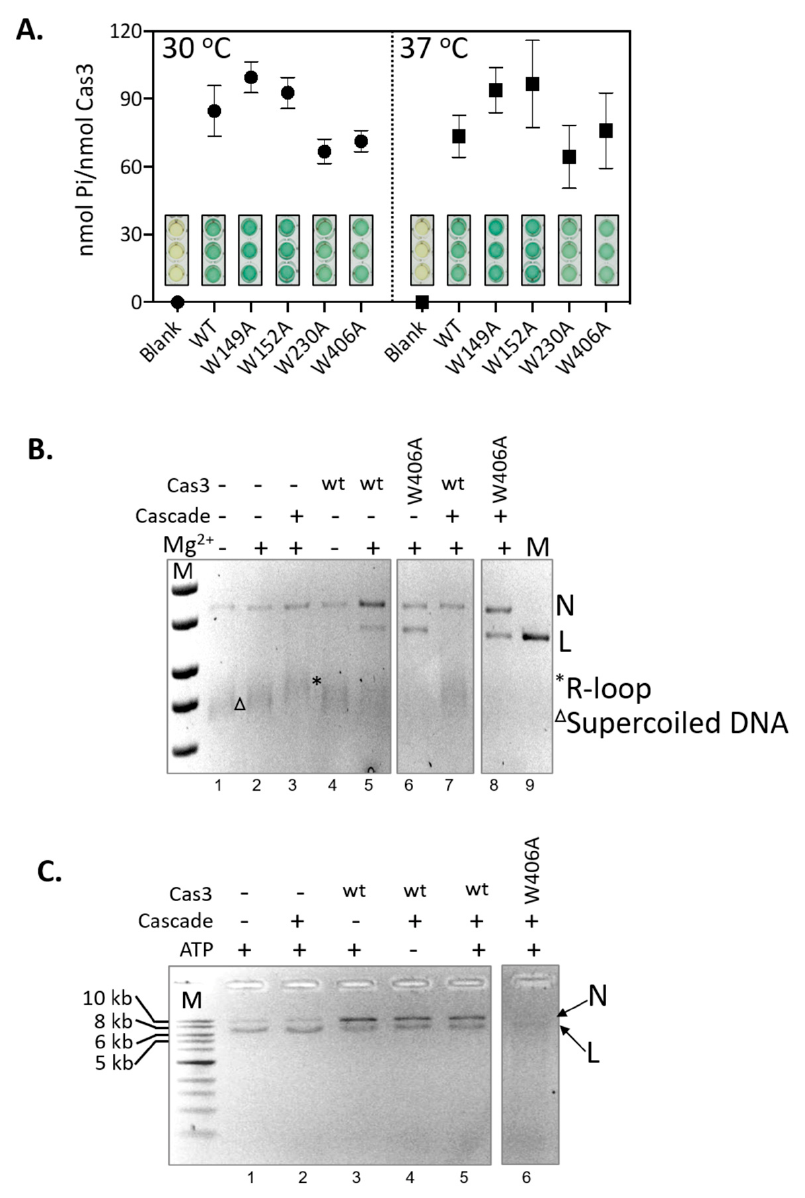
Figure 4. Nuclease hyperactivity of Cas3 W406A is independent of ATPase activity and interaction with Cascade. ( A ) End-point measurements of ATP hydrolysis by Cas3 proteins (790 nM) was compared at 30 and 37 ◦ C as indicated. Reactions were in triplicate, standard errors from the mean are shown, to give measurements of phosphate (Pi) released from per nM of Cas3 protein. These values were obtained from spectroscopic measurements of malachite green dye intensity, shown in the graph, each measurement was obtained after blanking the spectrophotometer with reactions lacking Cas3. ( B ) Shows Mg 2+ -dependent DNA nicking activity of Cas3 and Cas3 W406A (850 nM) on M13 DNA in reactions that contain preformed Cascade (100 nM) R-loop substrates, indicated by an *. Reaction components are as indicated above the ethidium bromide stained agarose gel panel. In these reactions no deproteinising ‘stop’ solution was added, so that we were able to visualise that Cascade R-loops had formed (e.g., lane 3). ( C ) Shows Cas3 nicking and nuclease activity in the presence of Mg 2+ and ATP and Cascade (100 nM), as indicated above the ethidium bromide stained agarose gel panel. These reactions were stopped by adding proteinase K ‘stop’ solution to dissipate R-loops so that nuclease products are more easily discerned. For panels ( B,C ) the topology of the DNA is highlighted to the right of the gel image by N (nicked) L (linear), * (R-Loop) and ∆ (Supercoiled).